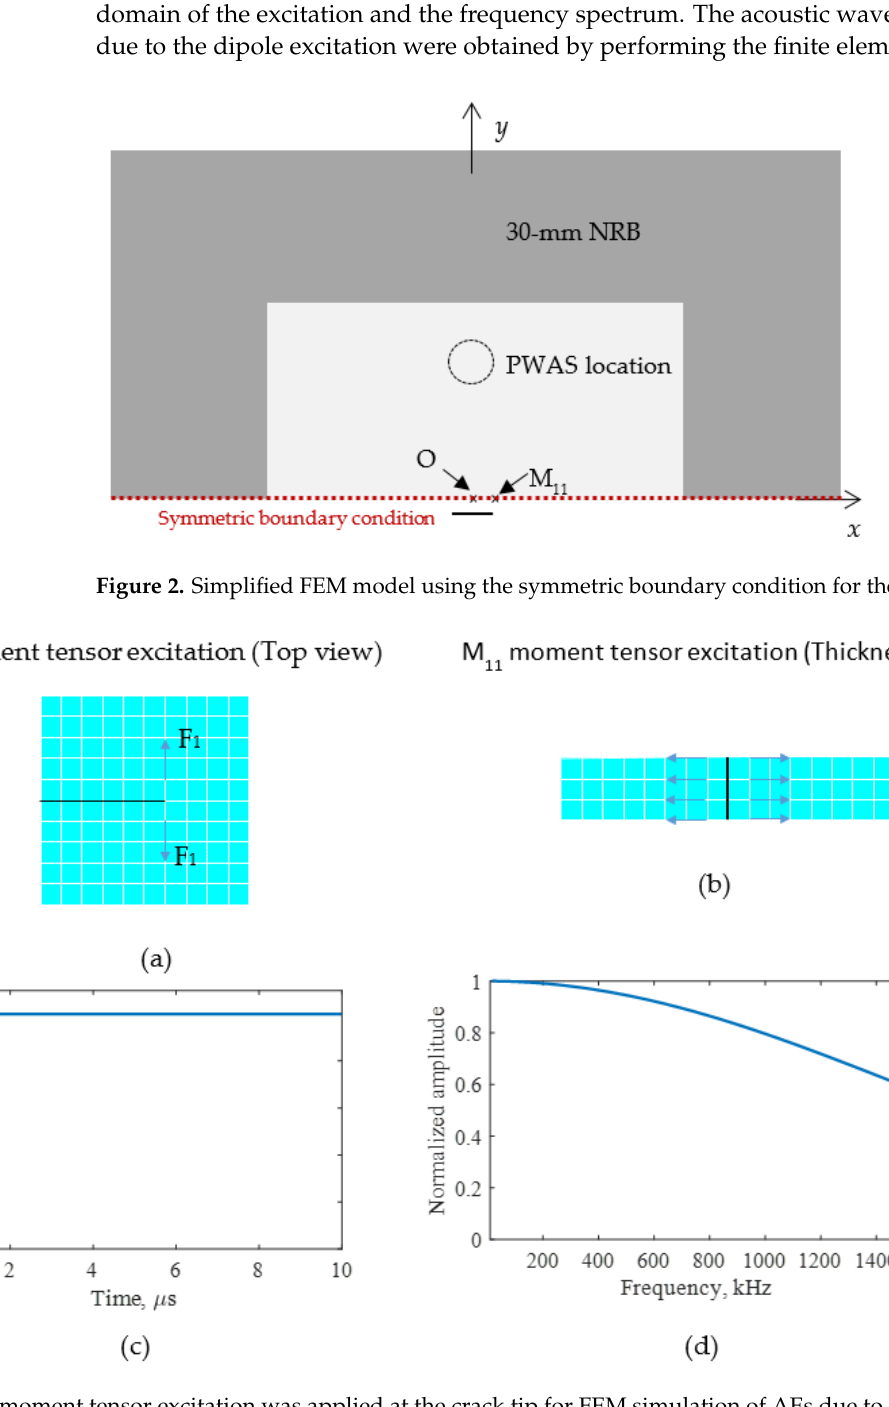
Figure 3. An M 11 moment tensor excitation was applied at the crack tip for FEM simulation of AEs due to crack growth. ( a ) Top view of the M 11 moment excitation generated using dipole forces (F 1 ); ( b ) thickness view of the M 11 moment exci- tation; ( c ) waveform of smooth-step excitation; ( d ) frequency spectrum of smooth-step excitation.